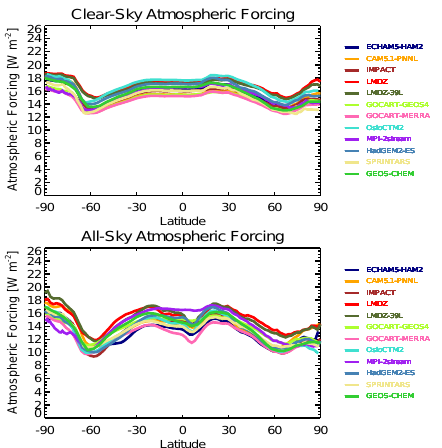
Fig. A6. Annual zonal-mean short-wave all-sky atmospheric radiative forcing (absorption) between experiments with AOD=0.2 and AOD=0.0 distributed over the lowest two kilometers, holding SSA=0.8 and ANG=1.0 constant (FIX3-FIX0).